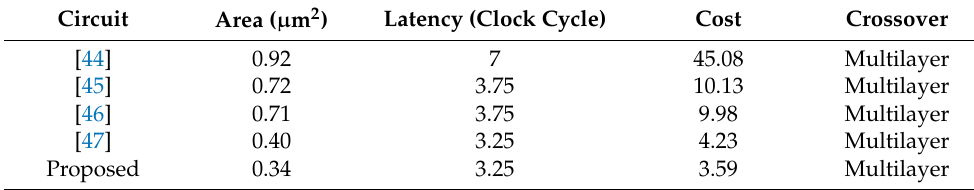
Table 6. Comparison of QCA 1 × 2